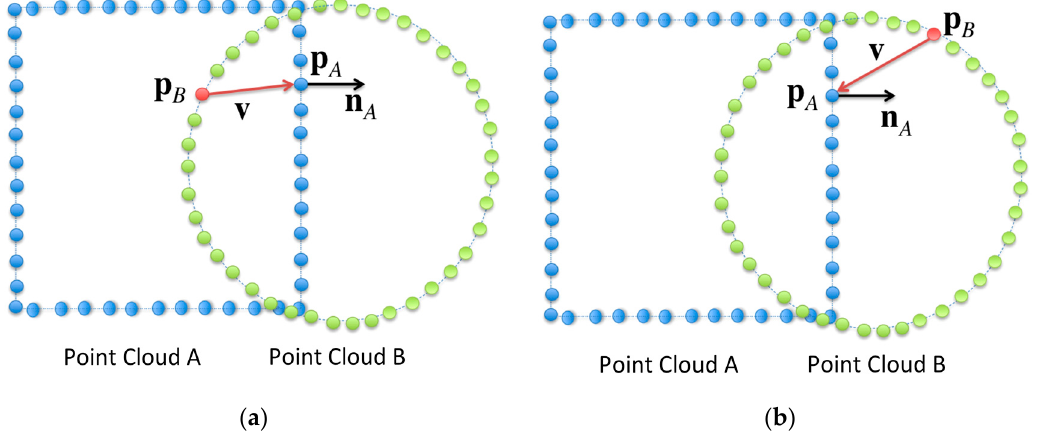
Figure 6. Detect the collision areas by using outward-pointing normal. ( a ) Inner product is greater than 0; ( b ) inner product is less than 0.